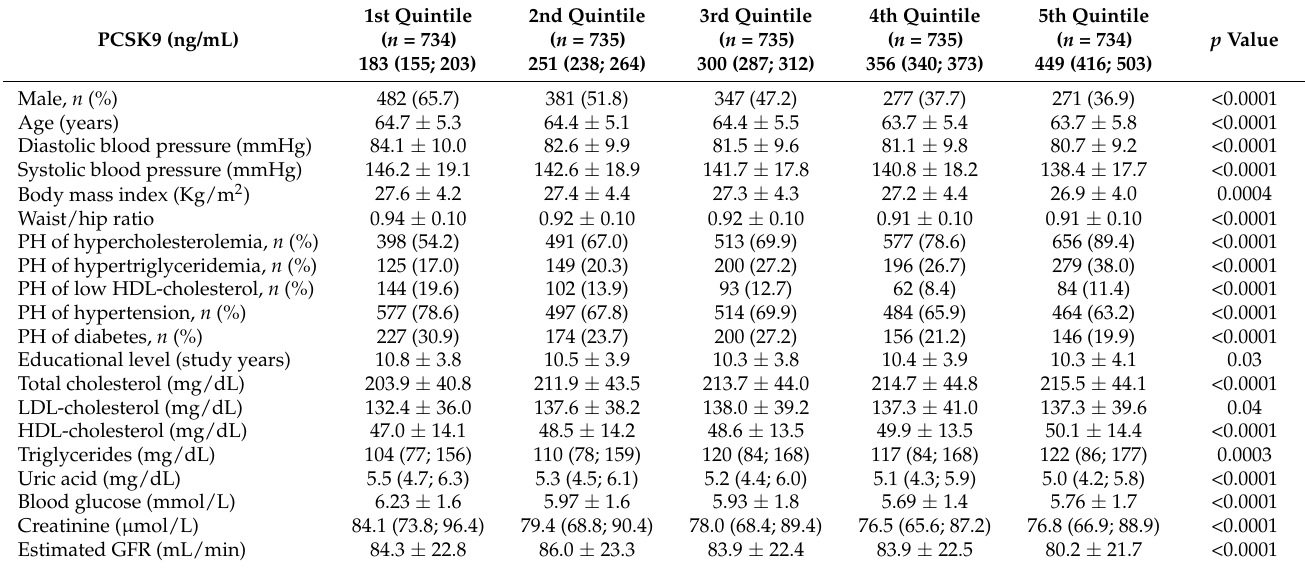
Table 1. Baseline characteristics of the IMPROVE study cohort stratified by quintiles of plasma PCSK9 levels (ng/mL). 1st Quintile 2nd Quintile PCSK9 (ng/mL) ( n = 734) ( n = 735) 183 (155; 203) 251 (238; 264) Male, n (%) 482 (65.7) 381